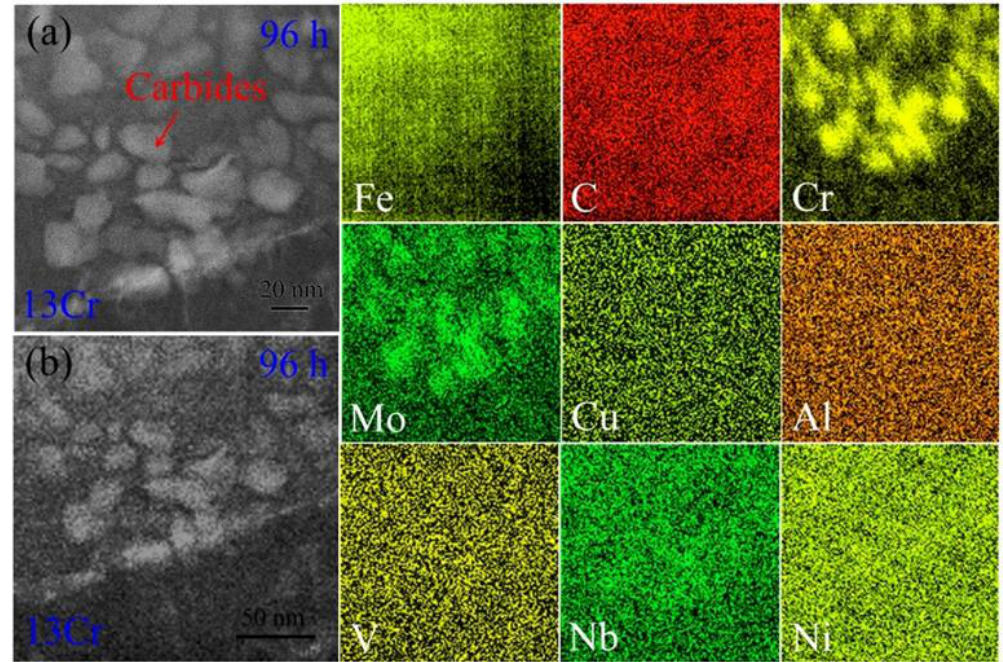
Figure 11. Element distribution of ferrite lath interior in the 13Cr samples crept for 96 h: ( a ) HAADF STEM image and ( b ) HAADF EDS maps of alloying elements, such as Fe, C, Cr, Mo, Cu, Al, V, Nb and Ni.